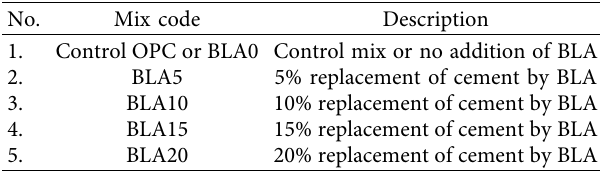
Table 6: Mix code designation.